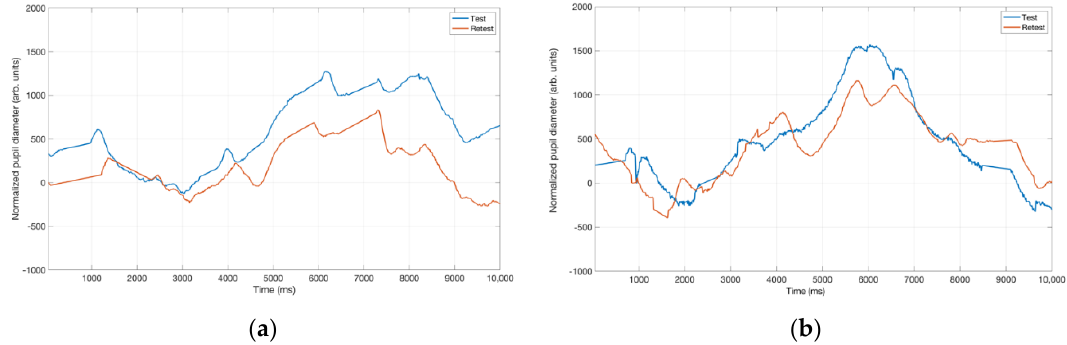
Figure 6. ( a ) Pupil tracks from a participant when listening to Talker 1 stimulus during the test and retest sessions. The Talker 1 stimulus was the 7th during the test session and 22nd during the retest session in terms of the presentation order. ( b ) Pupil tracks from a different participant when listening to the same Talker 1 stimulus. For this listener, the presentation order for Talker 1 stimulus was 21st and 11th during the test and retest sessions, respectively.